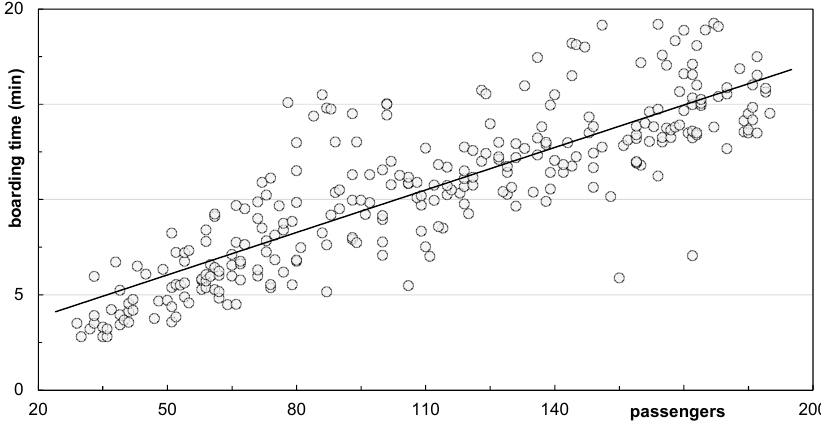
Figure 6. Boarding times of 282 measured flights with different numbers of passengers, assuming a linear correlation between passengers and boarding time (solid line).